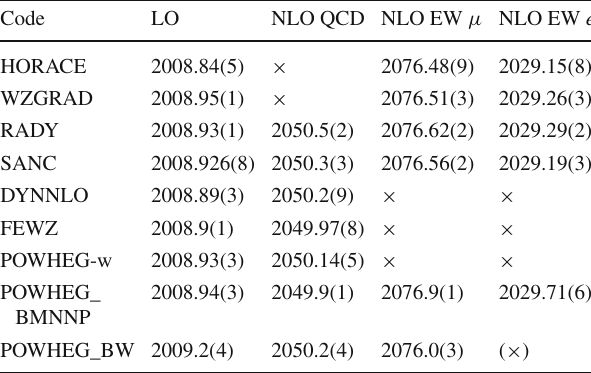
Table 5 Tuned comparison of total cross sections (in pb) for pp → W − → l − ¯ ν l + X at the 8 TeV LHC, with ATLAS/CMS cuts and bare leptons. ( × ) indicates that although POWHEG_BW provides NLO EW results also for bare electrons, due to the smallness of the electron mass it would require very high-statistics to obtain per-mille level precision. Thus, we recommend to use the bare setup in POWHEG_BW only